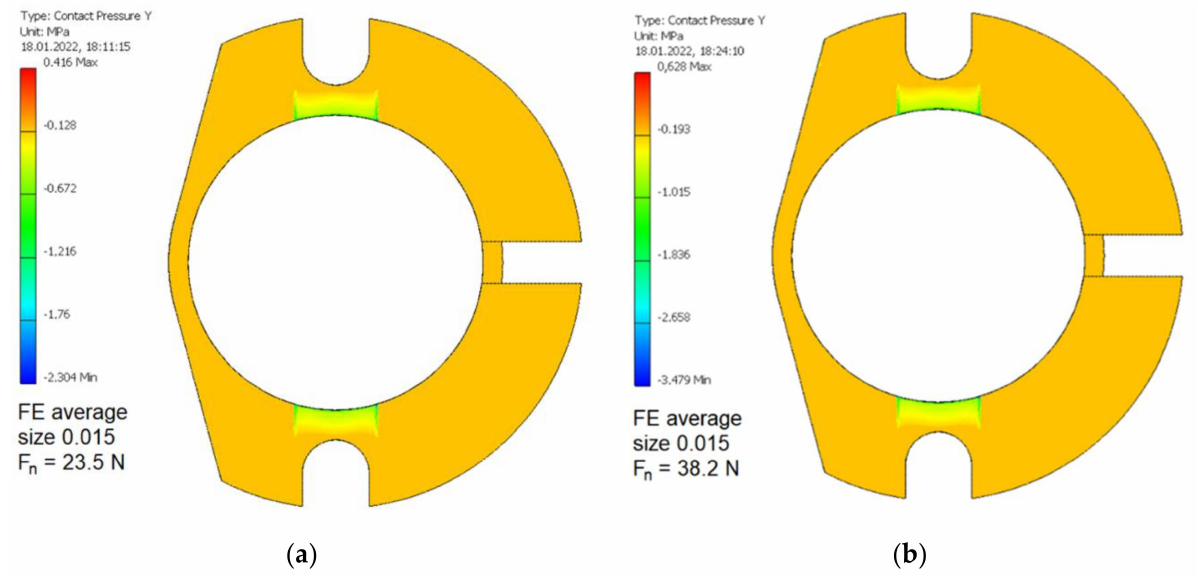
Figure 10. The values of normal contact pressure in two contact zones between the swivel arm and the bobbin case for the average FE relative size equal to 0.015 and two values of the normal force F n . ( a ) 25.3 N relating to milling with the course cutter ø4; ( b ) 38.2 N relating to milling with the finishing cutter